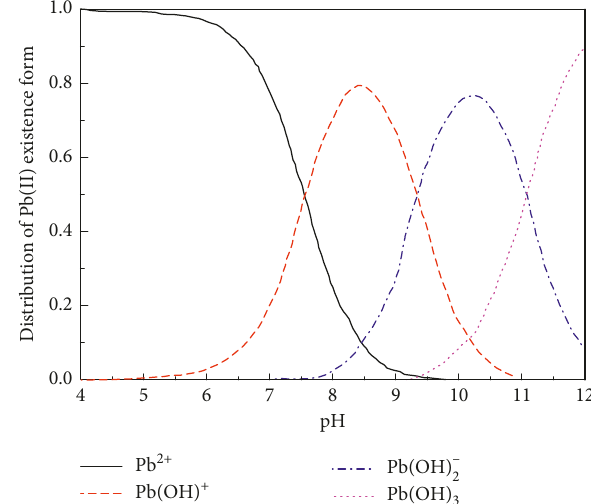
1 5g L (cid:30) · Figure 5: Distribution of Pb(II) existence form as a function of pH. −